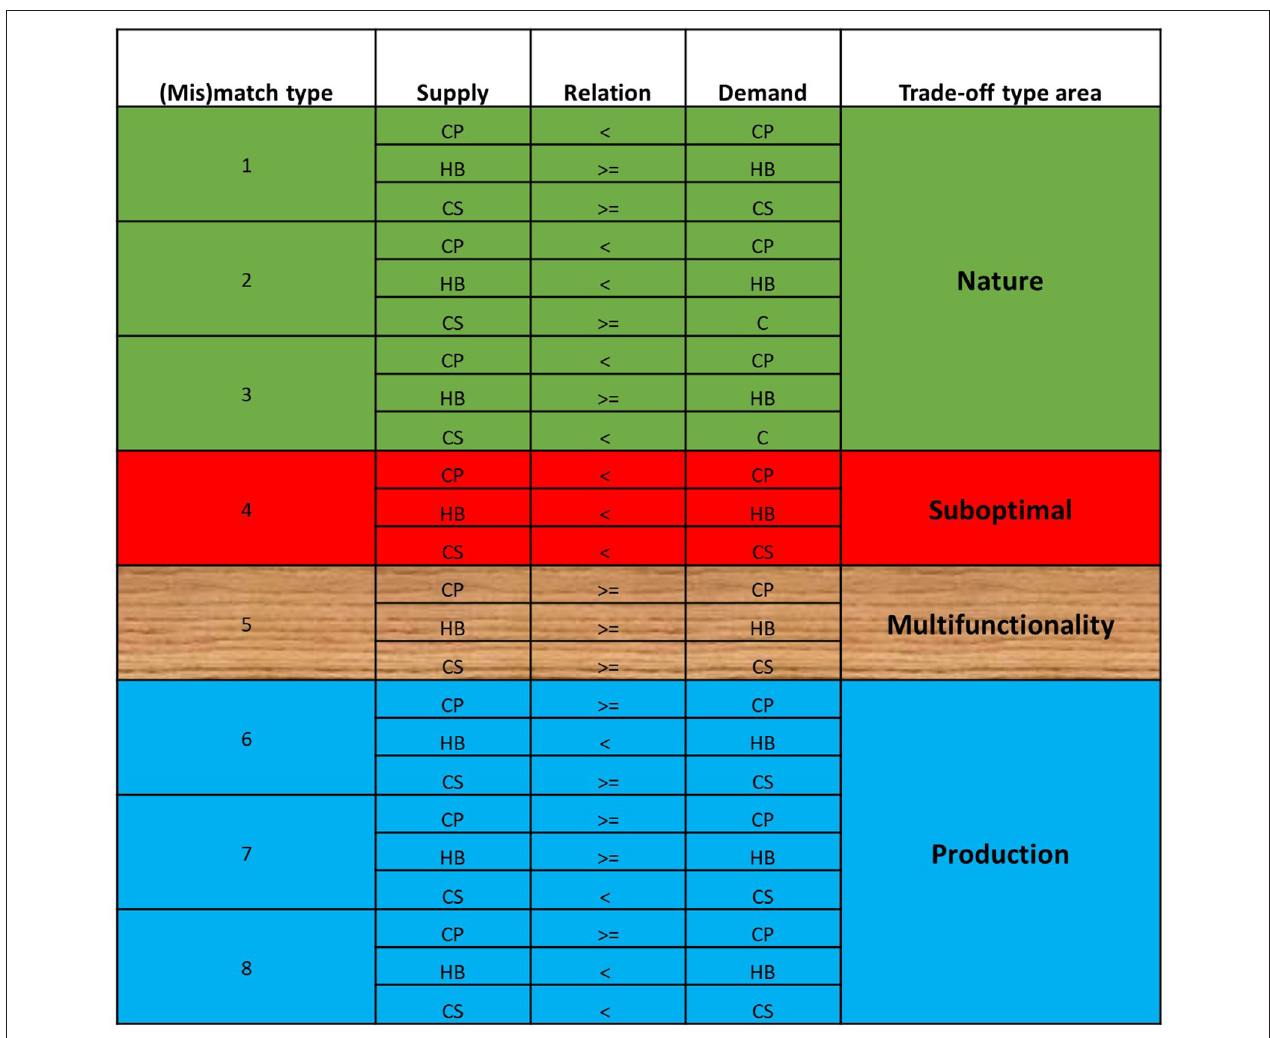
FIGURE 4 | Overview of possible combinations of (mis)matches between carbon storage (CS), habitat for biodiversity (HB), and commodity production (CP), and associated trade-offs.